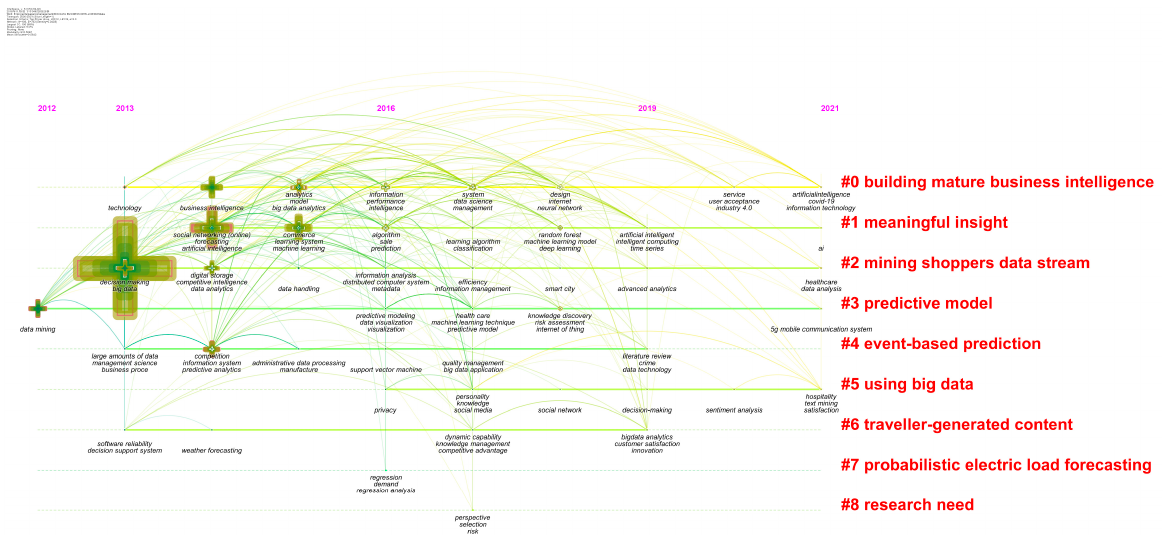
Figure 10. Developing a history of keywords and cluster visualization (The cross pattern represents the keyword).